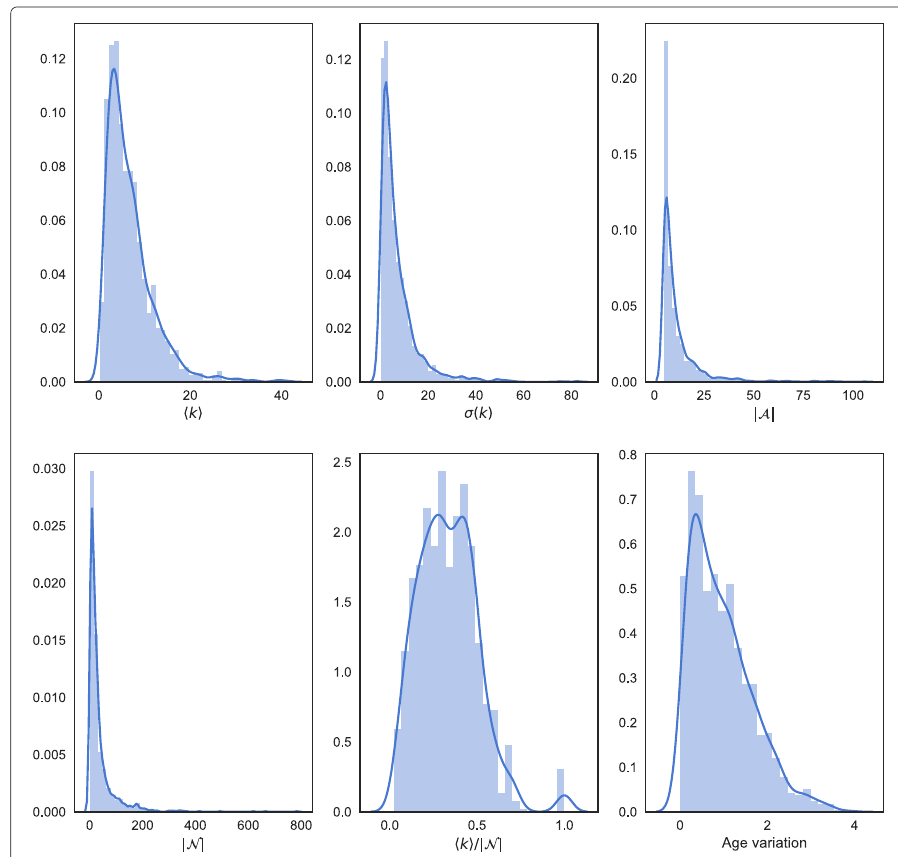
Fig. 6 Summary statistics of antichains and shared successors of those antichains, based on which they were obtained in hep-th citation network. In each case the relative frequency distribution is plotted over all the antichain communities found using successor neighbours, older neighbours who are cited by the newer papers in the antichain community. The statistics used are as follows: the average number of neighbours of each antichain node (cid:11) k (cid:12) , the standard deviation of the number of neighbours of each antichain node σ( k ) , the size of each antichain community | A | , the density of each bipartite graph (cid:11) k (cid:12) / | N | . The final panel shows the age variation of papers in each antichain. That is the standard deviation in the publication date of papers in each community, known in terms of months but we give the plot in terms of years